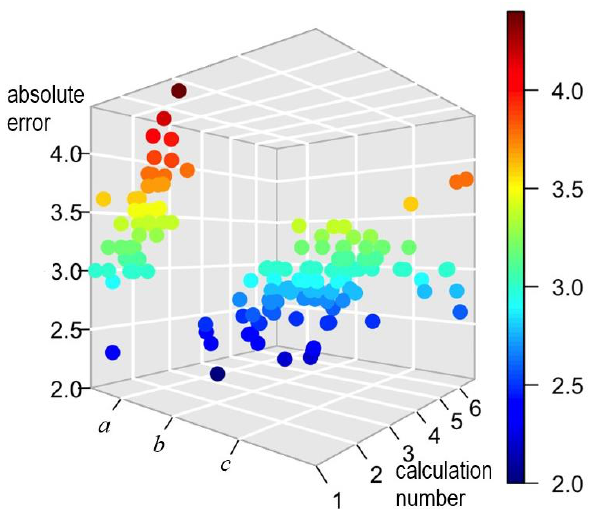
Figure 20. Calculation errors during mathematical modeling. a —ignoring the experimental data, b —taking into account the experimental data and the developed signal sampling system, and c —taking into account the experimental data but ignoring the developed signal sampling system.